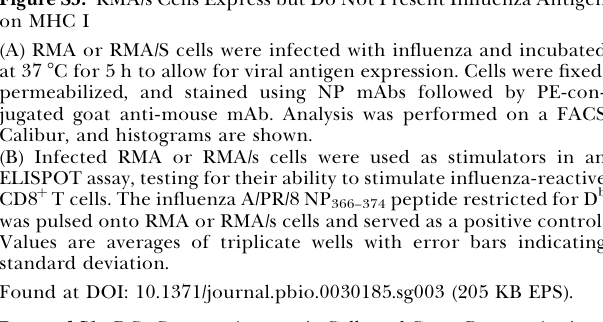
Figure S1. DC Cross-Presenting Apoptotic Cells Prime CD8 þ T Cells In Vivo and Serve As Targets for Effector CD8 þ T Cells In Vitro (A) C57BL/6 mice were immunized intra-footpad with 10 5 DCs cross- presenting apoptotic, influenza-infected PC3 cells, or apoptotic